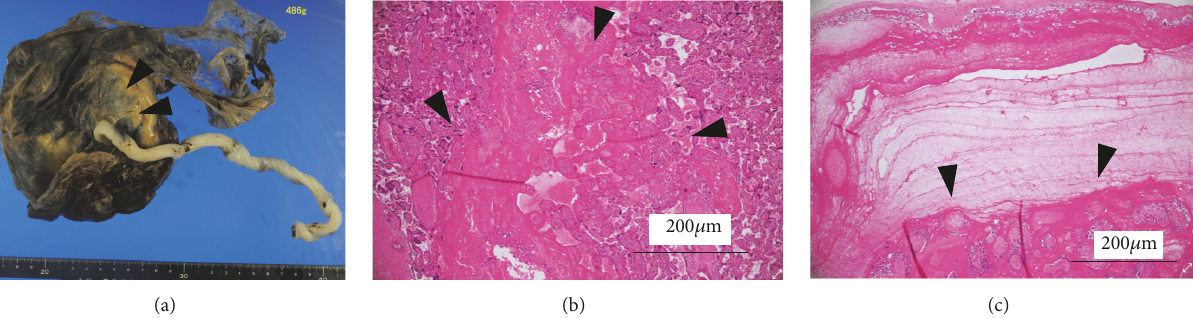
Figure3: Pathological findingsofplacenta. Macroscopicview andHEstaining areshown. Scale isshownineach figure. (a)Macroscopicview; circumferential-like infarction was observed in a portion approximately 4cm in radius around the umbilical cord. (b) x40 magnification. Necrosis of villi was observed around that site. Black arrows indicate the necrosis of villi. (c) x40 magnification. Necrosis of the amniotic membrane and chorion, and fibrin precipitation was observed. Black arrows indicate the necrosis, and fibrin